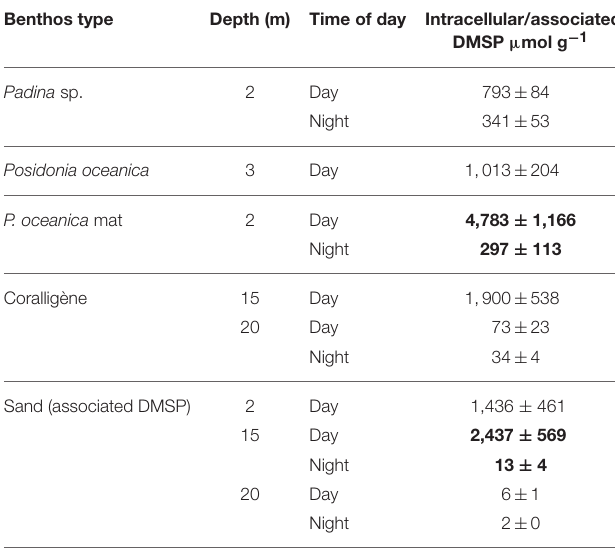
TABLE 1 | Intracellular and associated DMSP concentrations of key Mediterranean benthos. Benthos